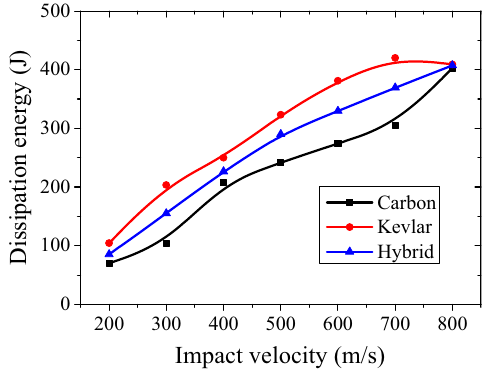
Figure 9: Simulated dissipation energy of